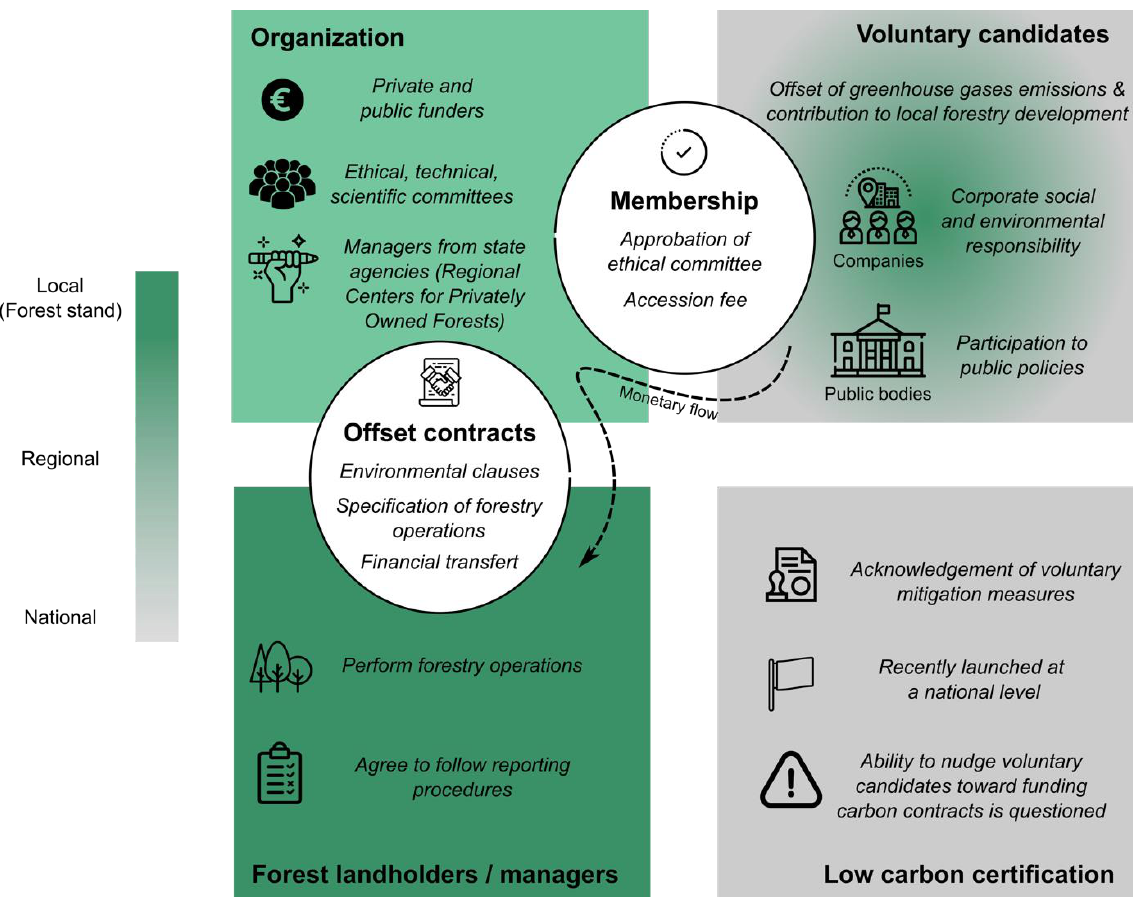
Figure 1. Internal functioning of the organizations offering voluntary carbon offset contracts.